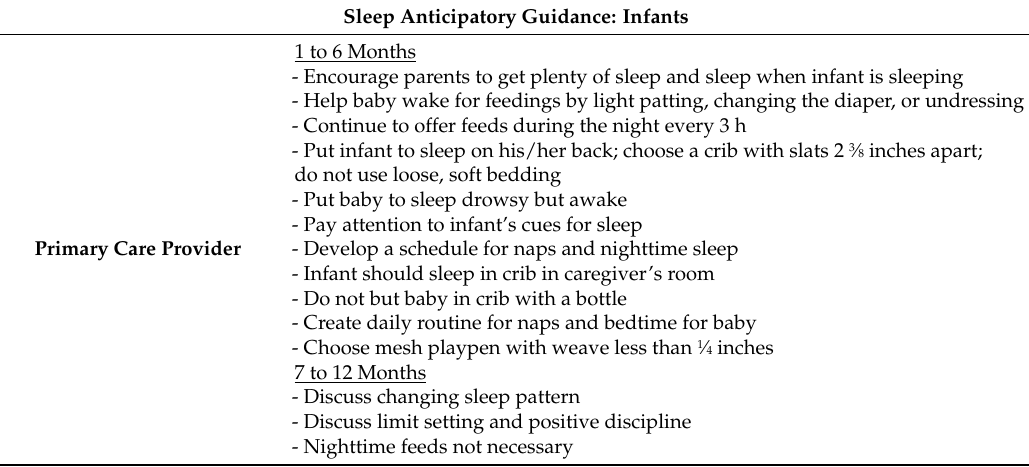
Table 1. Multidisciplinary anticipatory guidance recommendations [9,10,21–26]. Sleep Anticipatory Guidance: